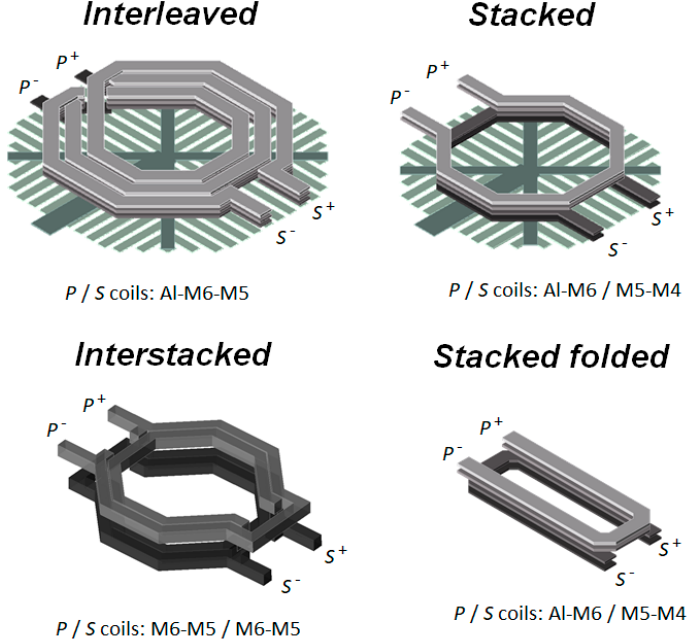
Figure 2. Integrated transformer configurations for RF/mm-wave operation. Reprinted with permission from ref. [9] . Copyright 2020, IEEE.